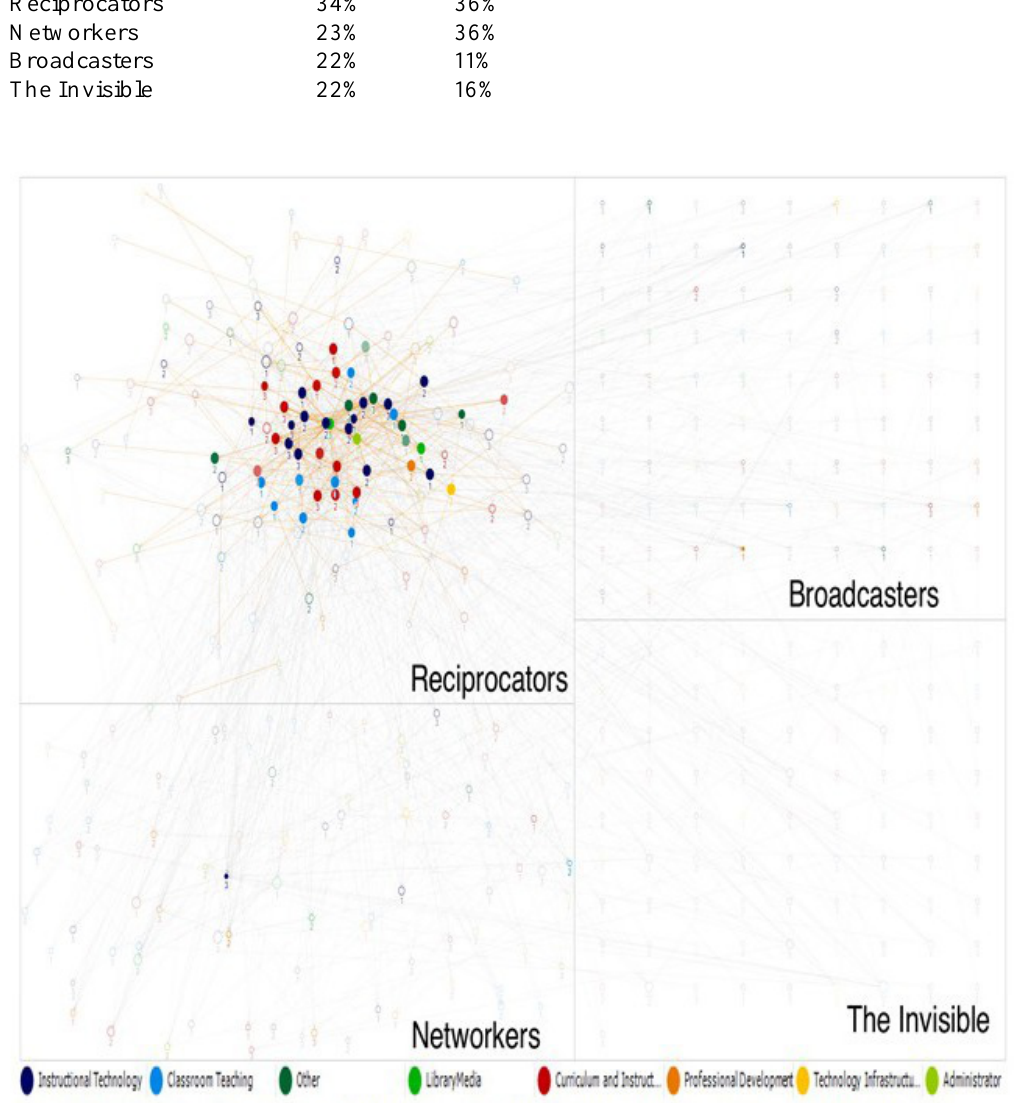
Figure 2. Sociogram of DLT peer-support network illustrating core-periphery and REGE